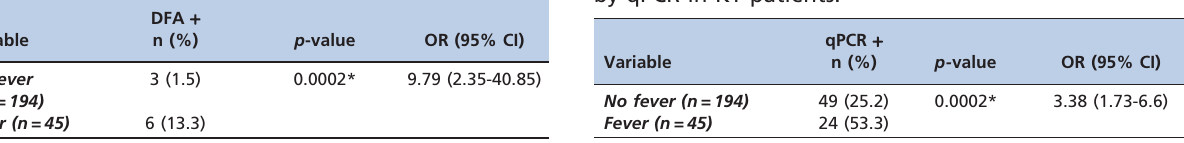
Table 3 - Univariate logistic regression analysis of the association between the presence of fever and positivity by qPCR in KT